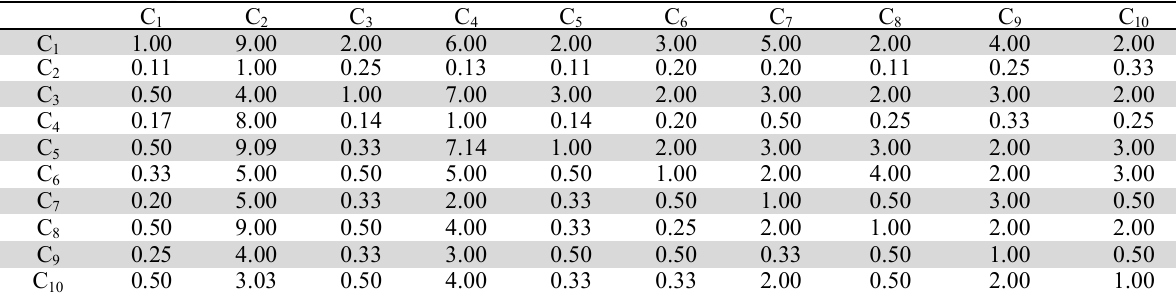
Pair wise comparison matrix of